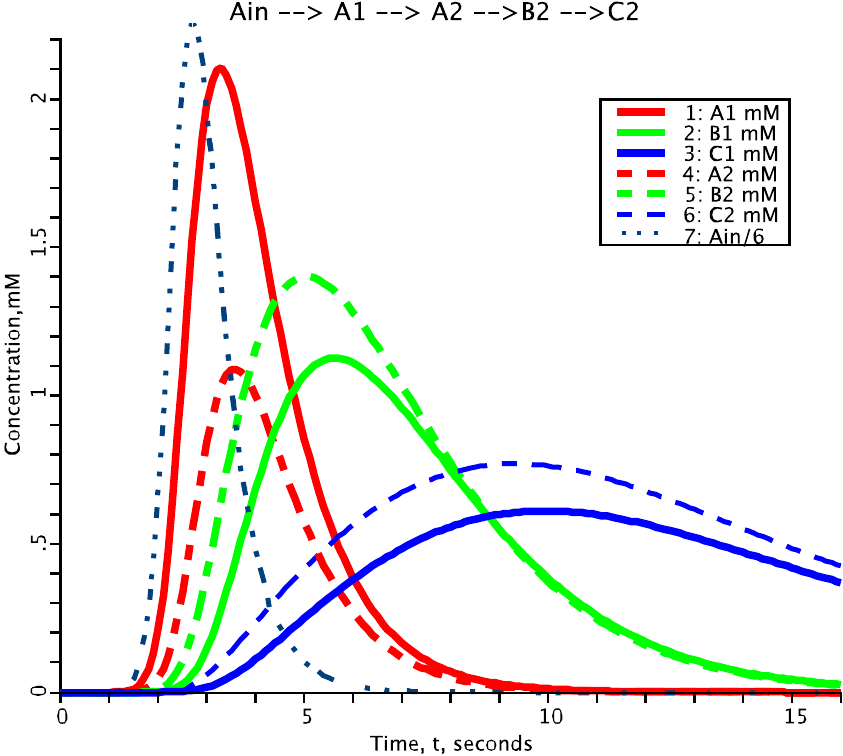
Figure 2. Solutions for the two compartment model generated from MPC. Species concentrations plotted as a function of time. Species A (red), B (green), C (blue). Compartment 1: solid line, Compartment 2: dashed line. A , the input function (black dot dashed line), is a lagged in normal density function for species A. Values for the input function are: Area under curve = 20 mM•sec, relative dispersion, RD = 0.25, skewn: 1.3, mean time: 3 sec.. See ‘MPC Ouput-Example.mod’ for other parameter values and initial